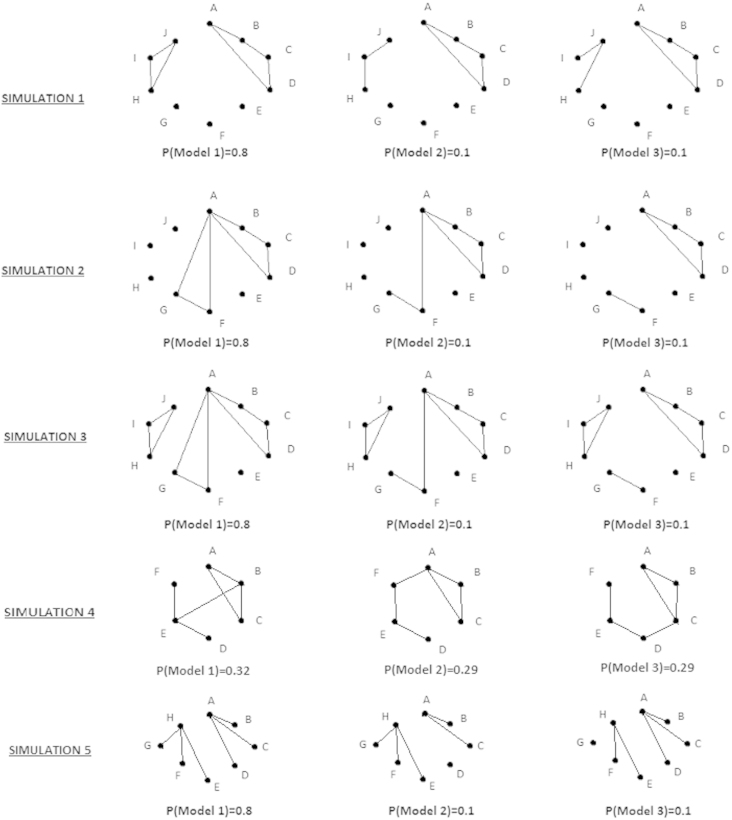
The graphical models used for the five simulations.